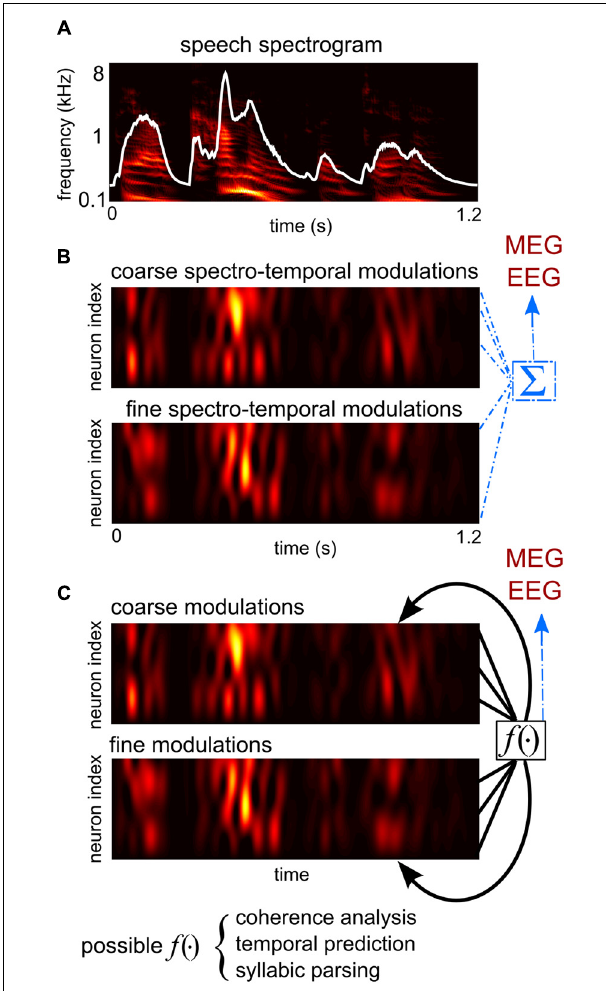
FIGURE 1 |A schematic illustration of hypotheses proposed to explain the generation of cortical entrainment to the speech envelope. (A) The spectro-temporal representation of speech, obtained from a cochlear model (Yang etal., 1992).The broad-band temporal envelope of speech, the sum of the spectro-temporal representation over frequency, is superimposed in white. (B) An illustration of the collective feature tracking hypothesis and the onset tracking hypothesis.The colored images show time courses of the dendritic activity of two example groups of neurons, hypothetically in primary and associative auditory areas. One group encodes the slow temporal modulations and coarse spectral modulations of sound intensity, i.e., the spectro-temporal envelope of speech, which contain major phonetic cues.The other group encodes the slow temporal changes of cues computed from the spectro-temporal fine structure, e.g., the pitch contour and the trajectory of the sound source location. According to the collective feature tracking hypothesis, magnetoencephalography (MEG)/electroencephalography (EEG) measurements are the direct sum of dendritic activity across all such neural populations in primary and associative auditory areas.The onset tracking hypothesis is similar, but instead neurons encoding the temporal edges of speech dominate cortical activity and thus drive MEG/EEG measurable responses. (C) An illustration of the syllabic parsing hypothesis and the sensory selection hypotheses. These hypotheses assume certain computations that integrate over distributively-represented auditory features.The syllable parsing hypothesis hypothesizes neural operations integrating features belonging to the same syllable.The sensory selection hypotheses propose either a temporal coherence analysis or a temporal predictive